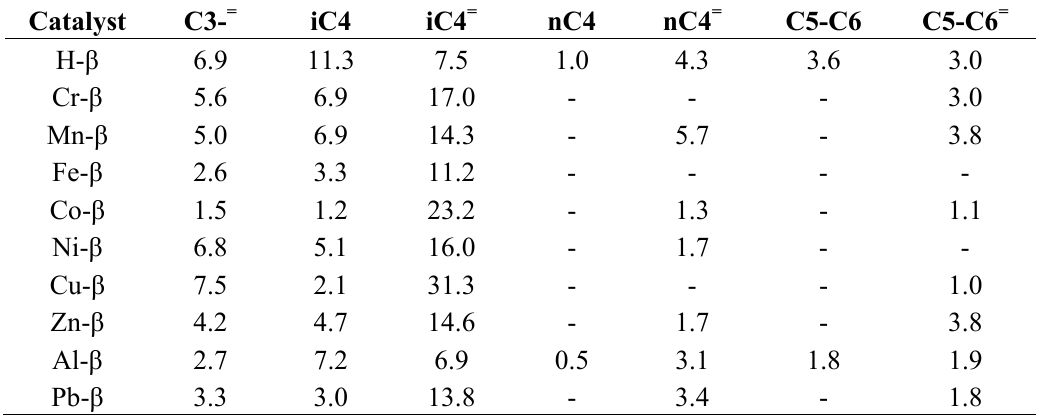
Table 4. Relative yields (wt %) to the compounds present in the aliphatic fraction. Catalyst